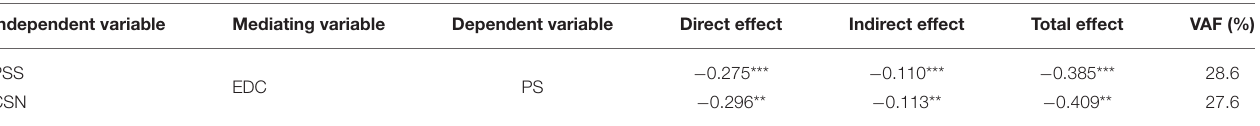
TABLE 5 | Bootstrap test of mediating effect.